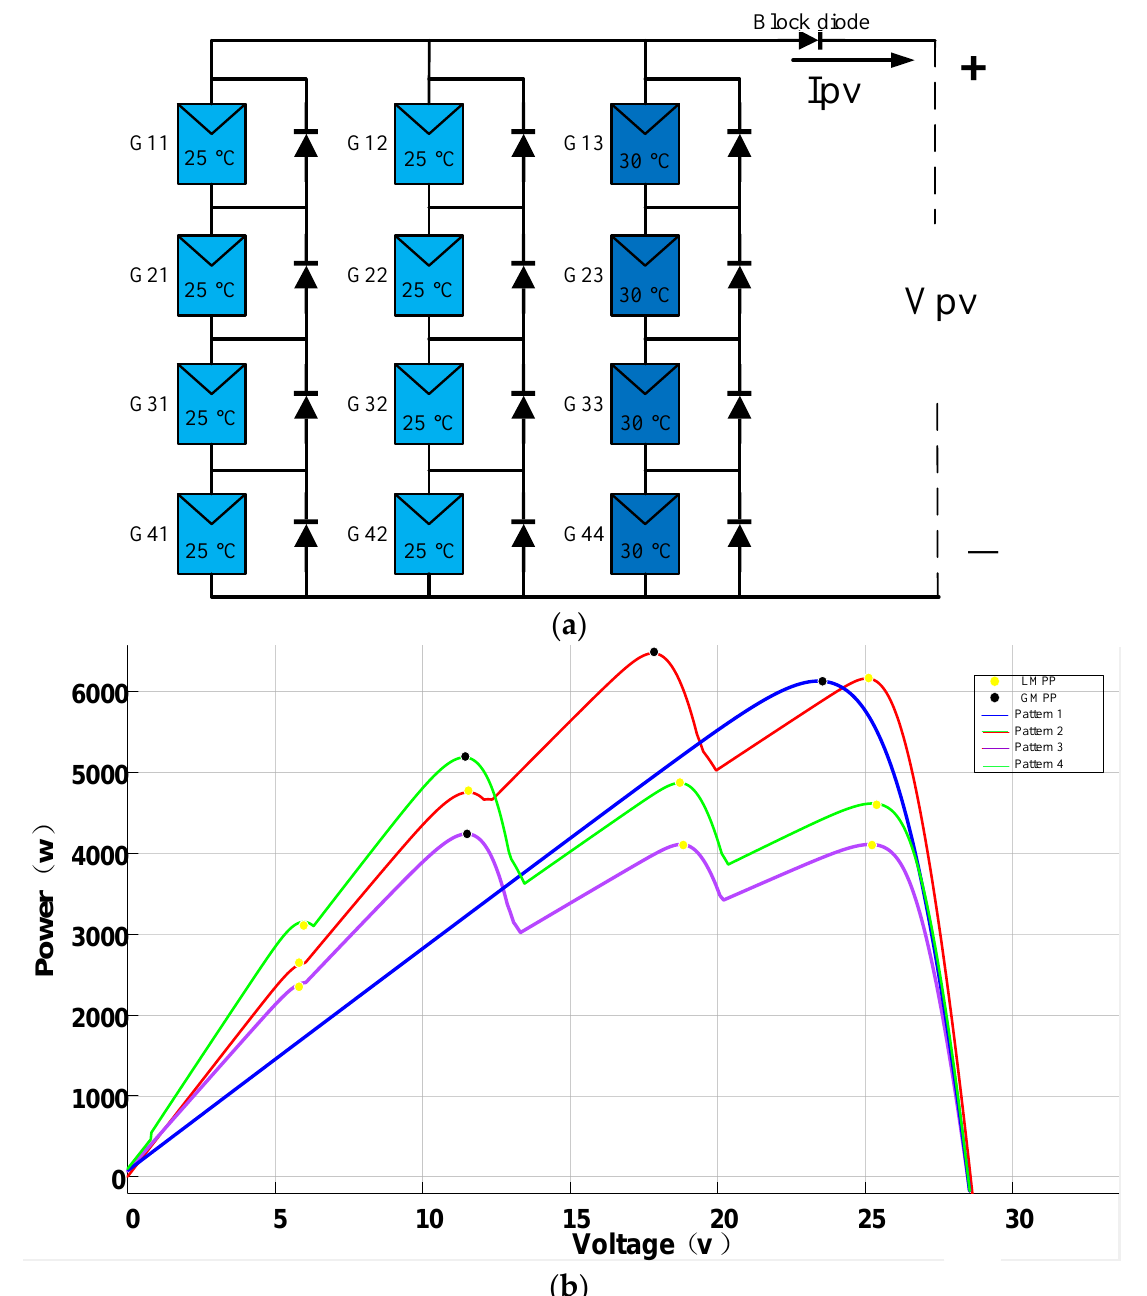
Figure 5. Partial shading analysis of the model PV system. ( a ) Shading patterns, ( b ) P − V curves under PSC.